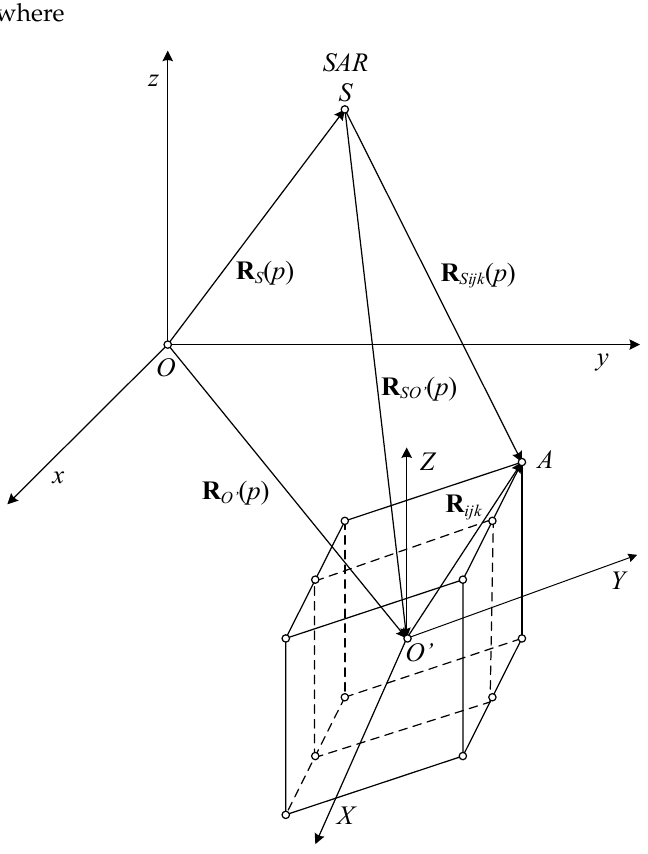
Figure 1. SAR geometry and kinematics. )()()( ppp RRR += denotes the distance vector SAR target’s mass center, '0'0 SS [ ] T = R denotes the ijk -th scattering point’s distance vector in the coordi- ijkijkijkijk ZYX ,, nate system XYZO ' , where )( XiX ijk Δ= )( YjY ijk Δ= and )( ZkZ ijk Δ= denote scat- tering point coordinates and X Δ , Y Δ and Z Δ denote the dimensions of the resolu- tion cell. 1,0 −= Np denotes the transmitted waveform’s index; N denotes the number of waveforms illuminating the object during the aperture synthesis. denotes the SAR distance